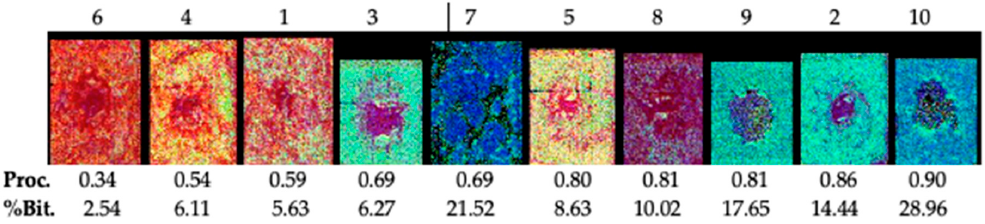
Figure 9. Color composite of froth hyperspectral imagery in continuum removed reflectance (red = 1750 nm, green = 2167 nm, blue = 2205 nm). The sample ID is shown above each image. Processability values (Proc.) and % bitumen in froth (%Bit.) for each sample are shown below imagery. Samples with a predominance of illite-smectite clays in the froth display red color imagery (relatively depressed 2005 nm blue channel continuum-removed reflectance, thus appearing red in this composite).